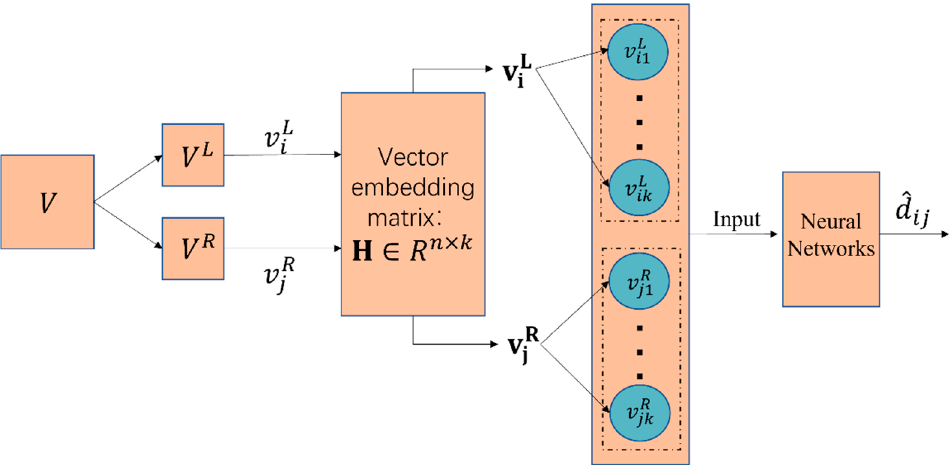
Figure 4. Base architecture of ndist2vec.